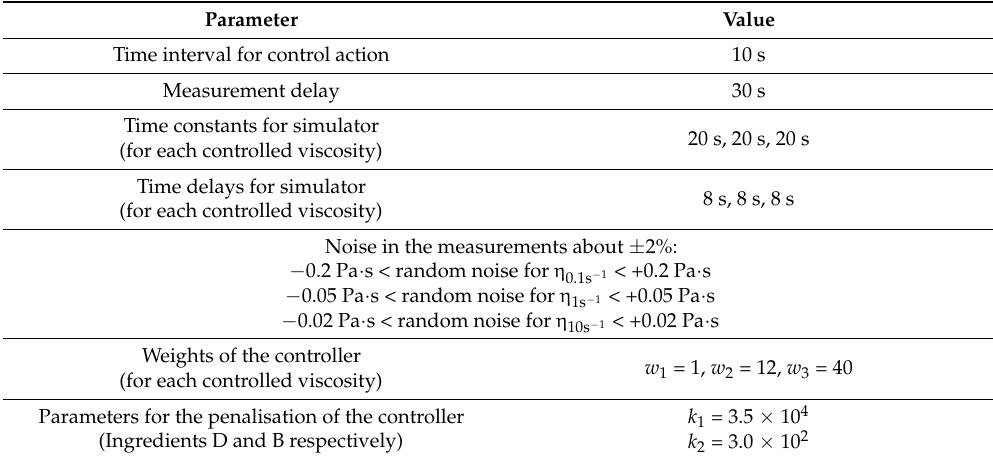
Table 3. Specifications for the reference